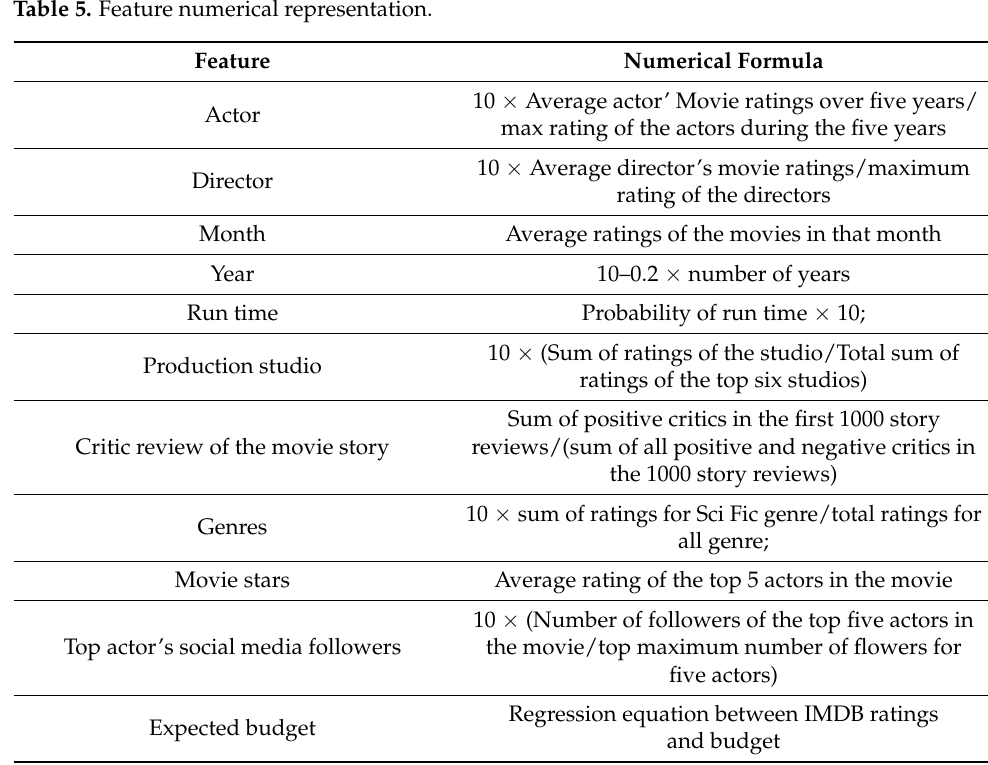
Figure 6. Implementation Model.